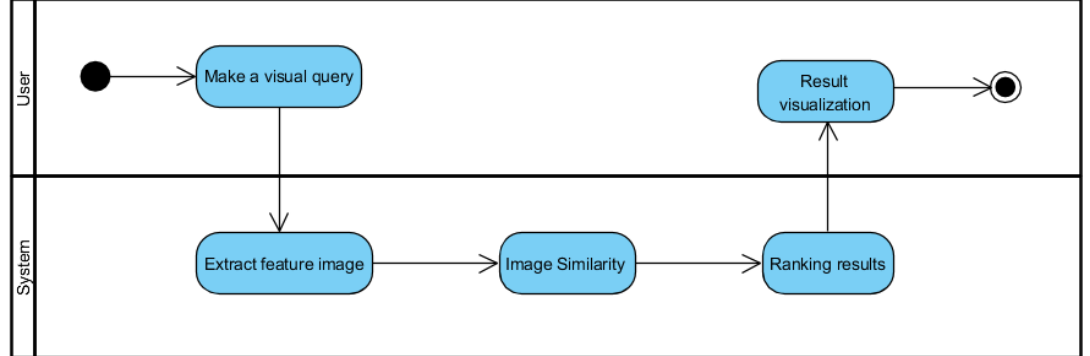
Figure 6. Activity diagram: visual query (Case